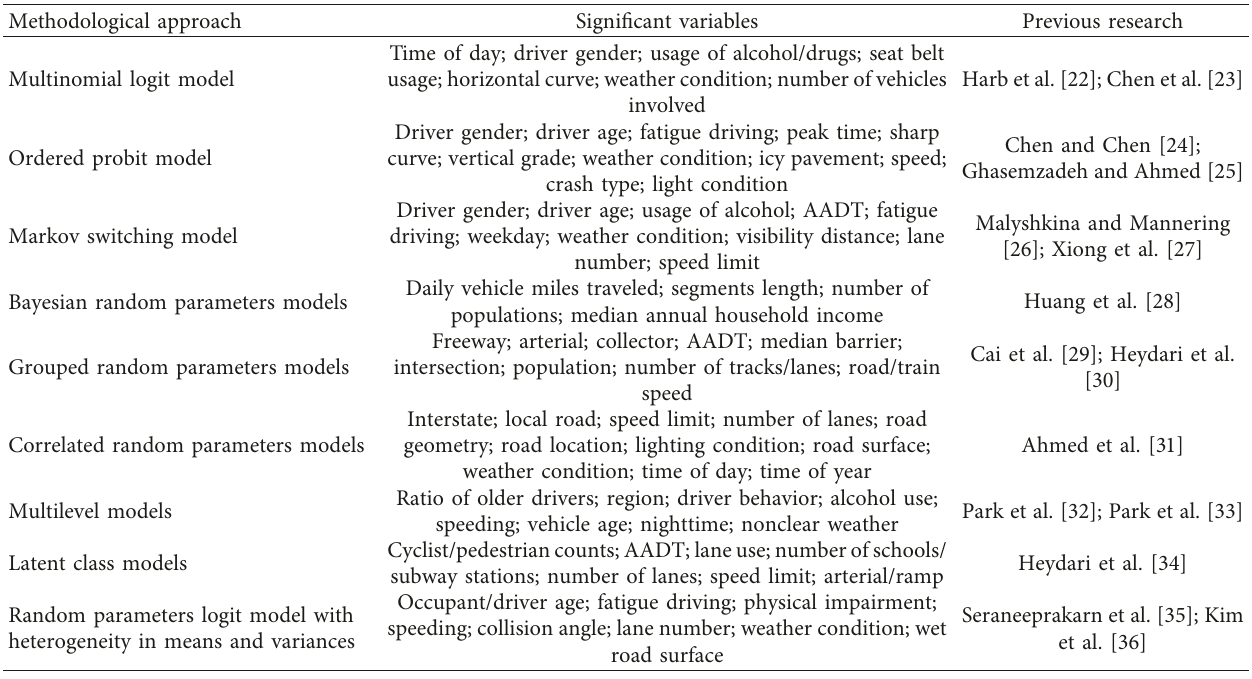
Table 1: Summary of approaches in the analysis of crash